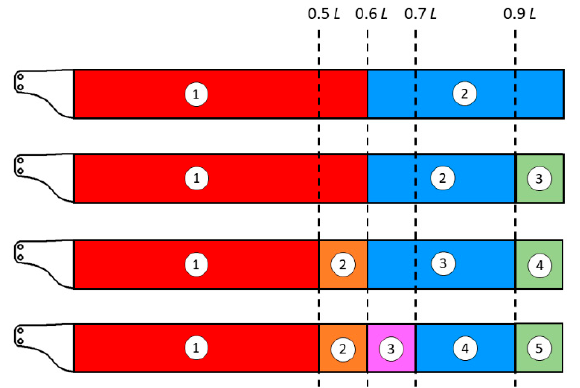
Figure 21. Optimal segment layouts.